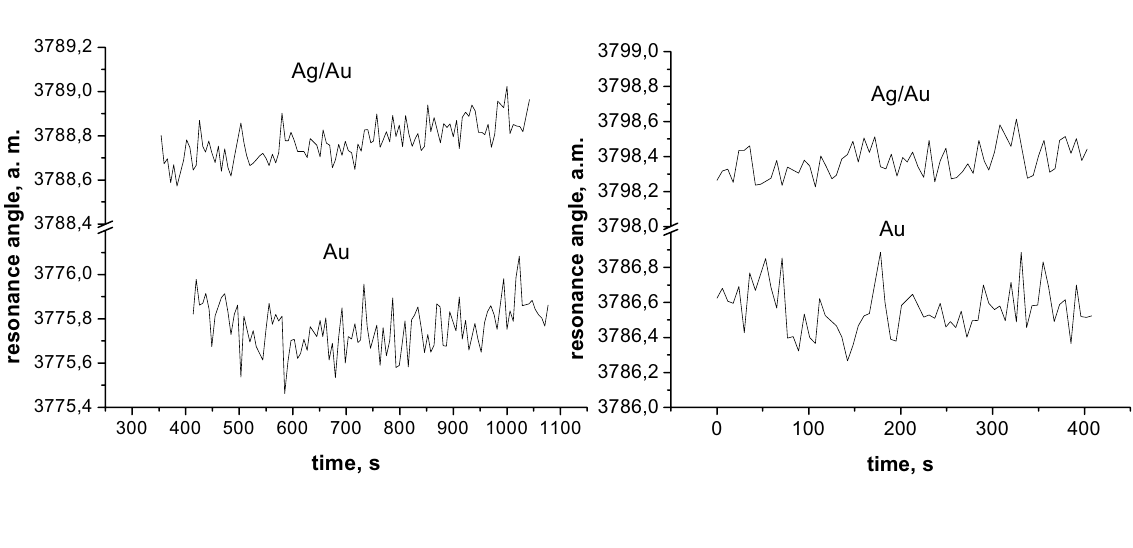
Figure 6. Typical records of noise of resonance angle measured with gold and with bimetallic silver/gold (thickness 1:1, silver as inner layer) in water (left) and after adsorption of bovine serum albumin (20 µg/ml) in 150 mM KC, 5 mM phosphate, pH 7.0